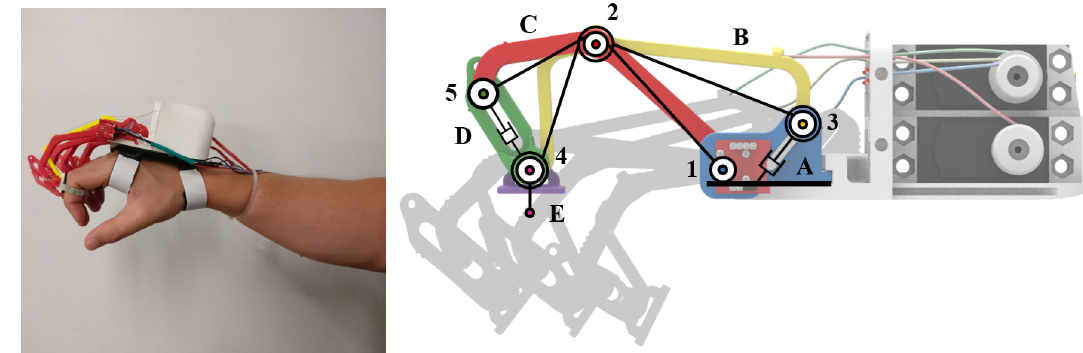
Figure 5. The figure shows, on the left, the second version of the exoskeleton system worn by a healthy subject and, on the right, the corresponding kinematic chain and CAD model. Colors and names (capital letters) of the components, and joints enumeration are reported as introduced in Section